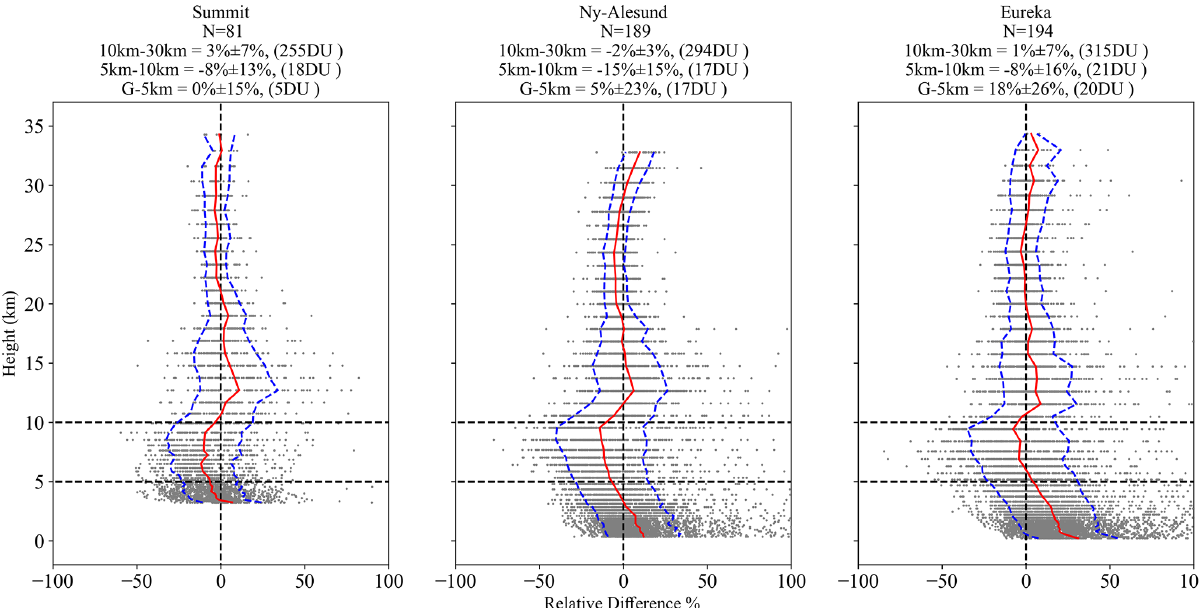
Figure 3. Relative differences of ozonesonde and MERRA-2 at each layer at three sites from 1 December to 1 May for 6 years of SSWs. The relative difference is the subtraction of ozonesonde from MERRA-2 ozone dataset divided by ozonesonde for each layer. The normalized mean bias is shown by the red line. The standard deviation of the relative differences from the normalized mean biases are shown by the blue lines. The number of coincident ozonesonde and MERRA-2 comparisons between 1 December and 1 May for the 6 years of SSWs ( N ) is shown under each site name. The mean and standard deviation of PCO relative differences for three layers (10–30, 5–10, ground–5km) are summarized for each site. The average PCO value for each layer is shown in